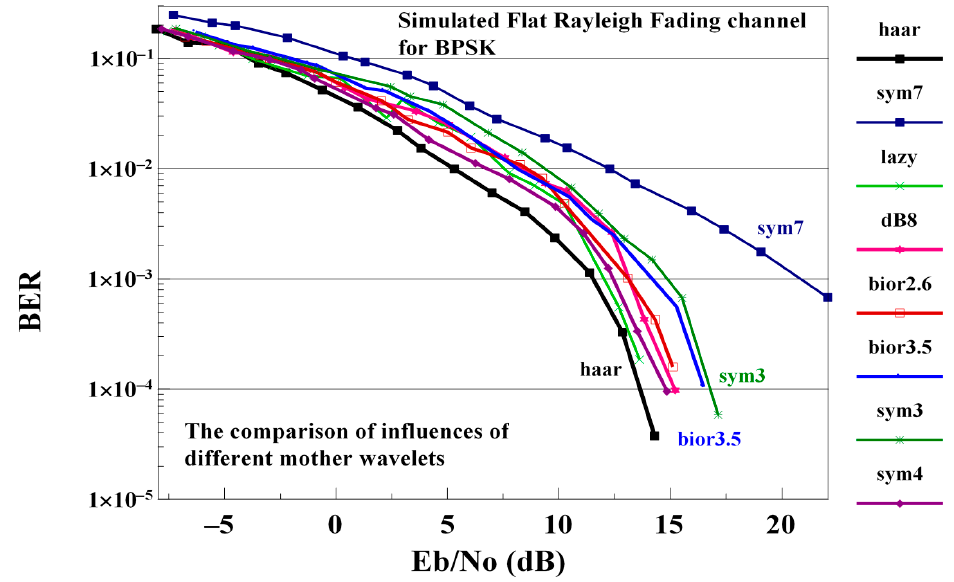
Figure 7. A comparison of the performance of the proposed waveform in case of flat Rayleigh fading channel obtained using different mother wavelets.